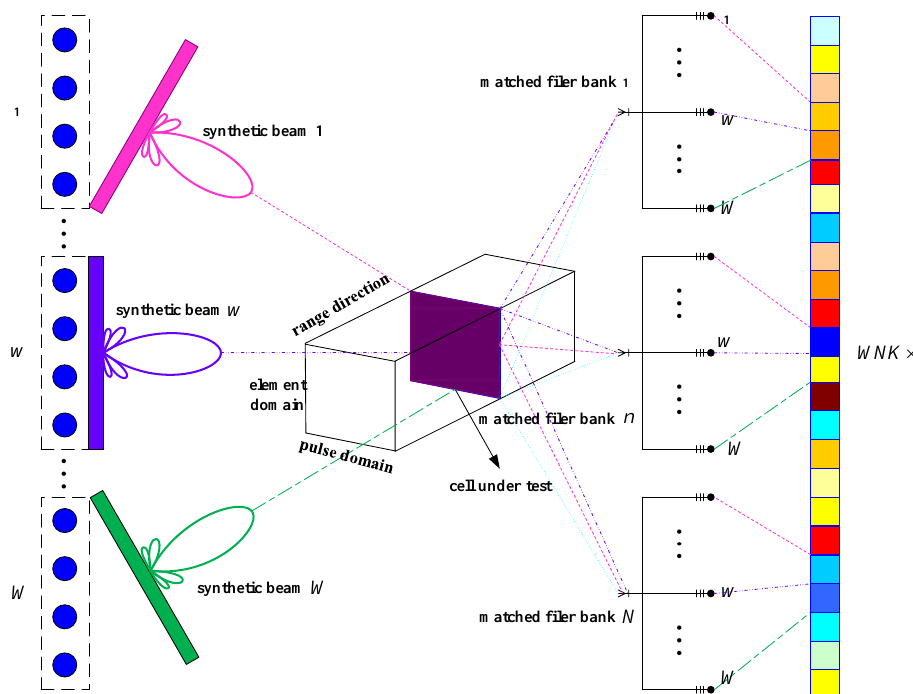
Figure 3. Schematic diagram of acquiring the echo data by the airborne active array radar with transmitting subarray diversity.